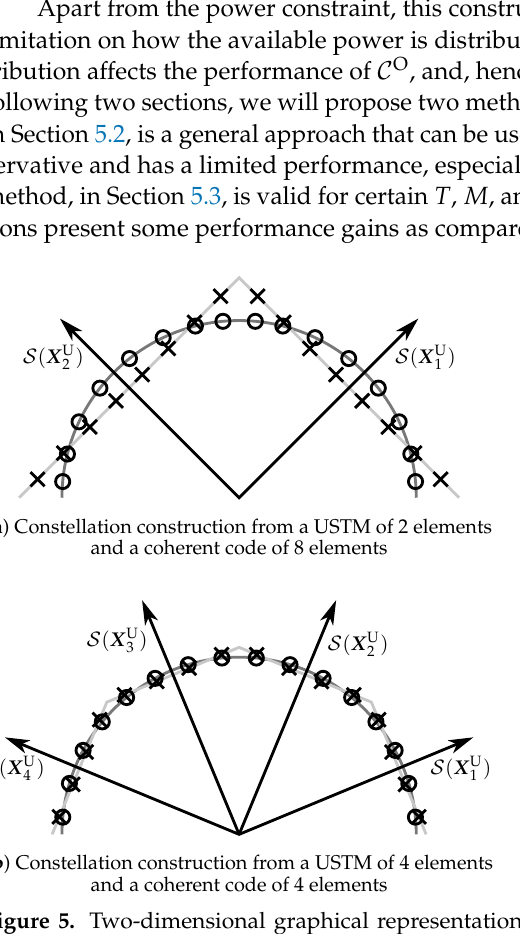
Figure 5. Two-dimensional graphical representation of the elements of the PSAMs constructed combining a USTM and a coherent code (with ‘ × ’ symbols), and the orthonormalization of these elements (with ‘ ◦ ’